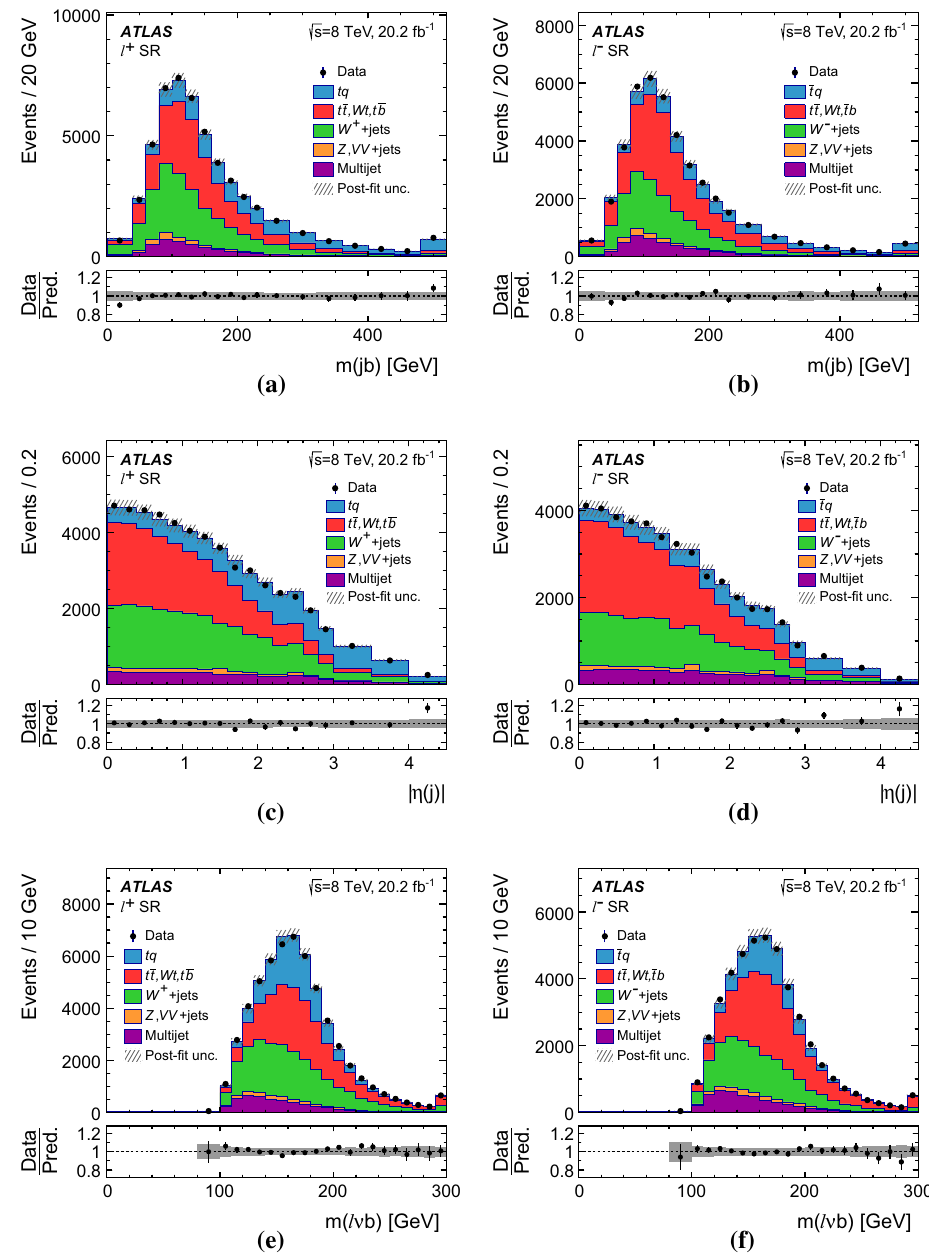
Fig. 7 Observed distributions of the three most important input vari- ables to the NN in the SR compared to the model obtained with simu- lated events. The definitions of the variables can be found in Table 2. The simulated distributions are normalised to the event rates obtained by the maximum-likelihood fit to the NN discriminants. The hatched